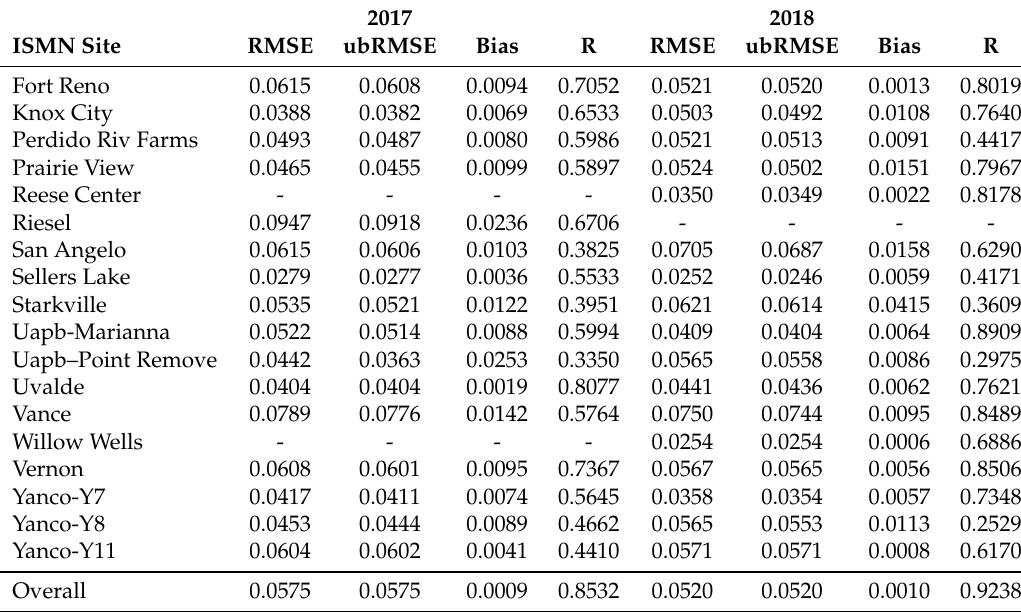
Figure 8. Scatter plots of SM retrievals for the entire data set, year 2017, and year 2018. RMSE, ubRMSE, and bias are given in [cm 3 /cm 3 ]. Pearson’s R is also provided. N is the number of data points. Table 5. SM retrieval algorithm performance statistics. RMSE, ubRMSE, and bias are expressed in [cm 3 /cm 3 ]. Pearson’s R is also